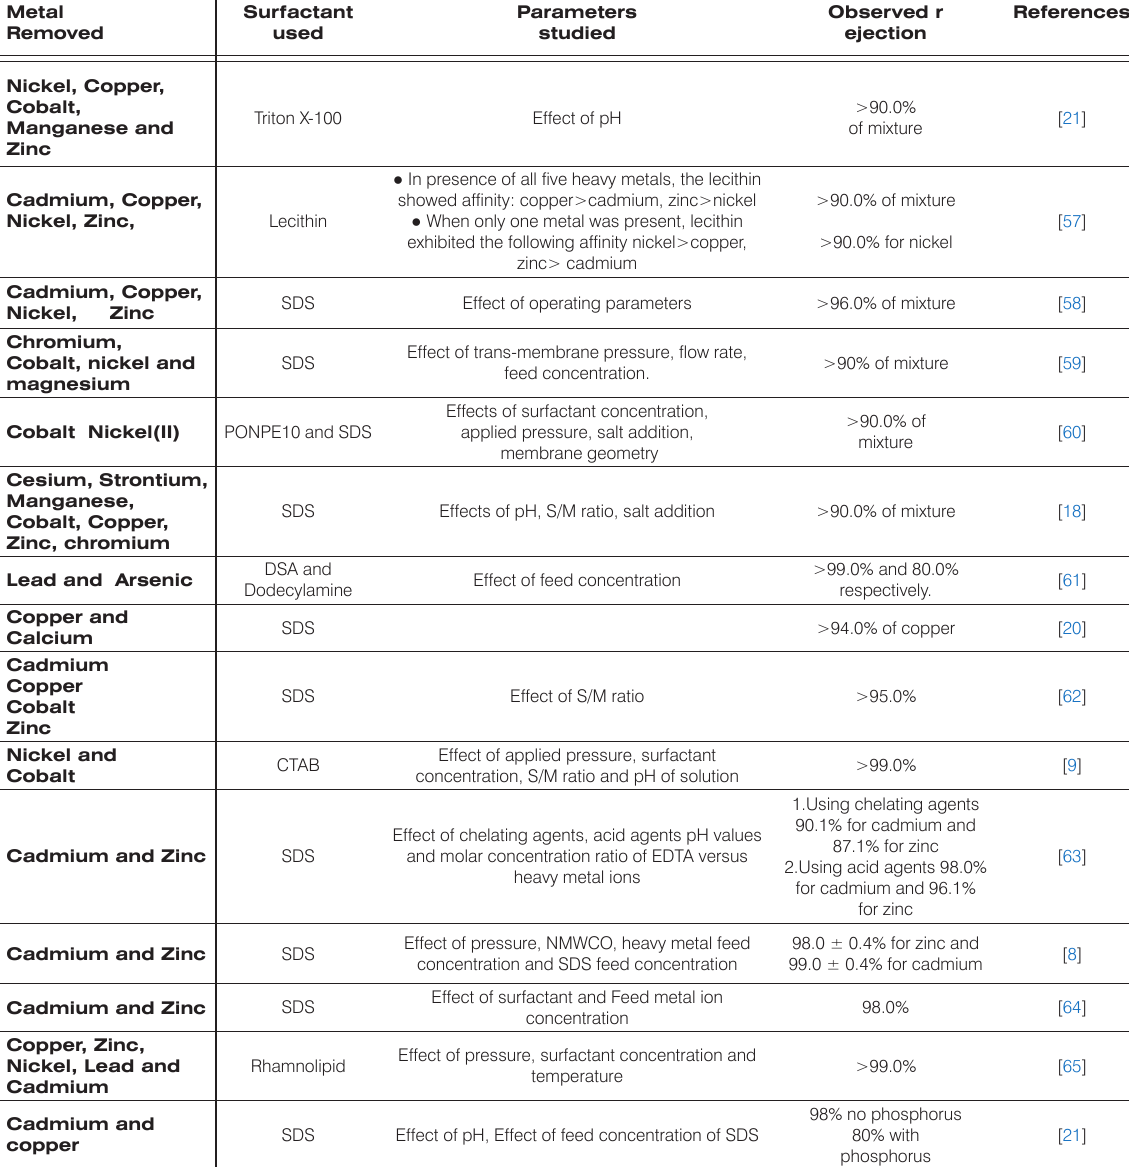
Table 3. Removal of mixture of metal ions by MEUF